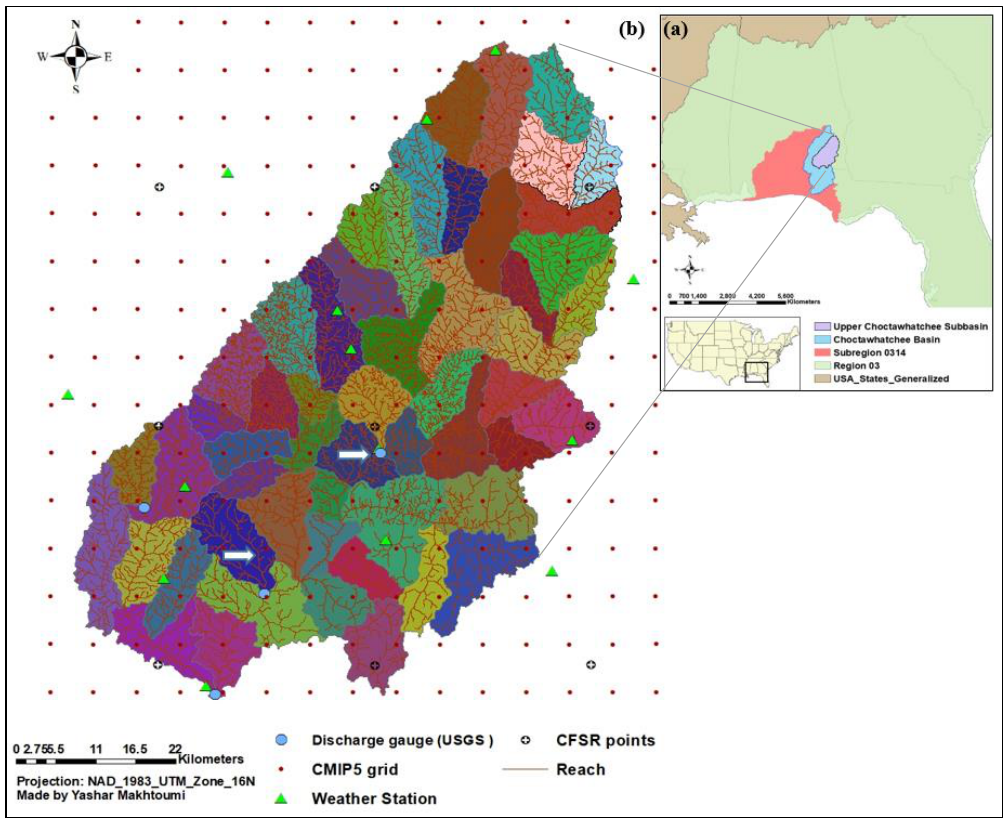
Figure 1. ( a ) Location of Upper Choctawhatchee Subbasin (UCS) in the Southeast of the USA. The legend represents the hydrologic division order from Region to Subbasin. ( b ) UCS delineation and 54 subwatersheds. Big blue dots represent the location of US Geological Survey (USGS) discharge gages; small black dots represent the Coupled Model Intercomparison Project 5 (CMIP5) grid; yellow rectangles indicate the weather station locations; plus marks indicate Climate Forecast System Reanalysis (CFSR) points; and reaches were shown in green lines. Monitoring points are also shown with white arrows where the upper station is Newton (NW) (USGS2361000) and the lower station is Bellwood (BL) (USGS2361500).